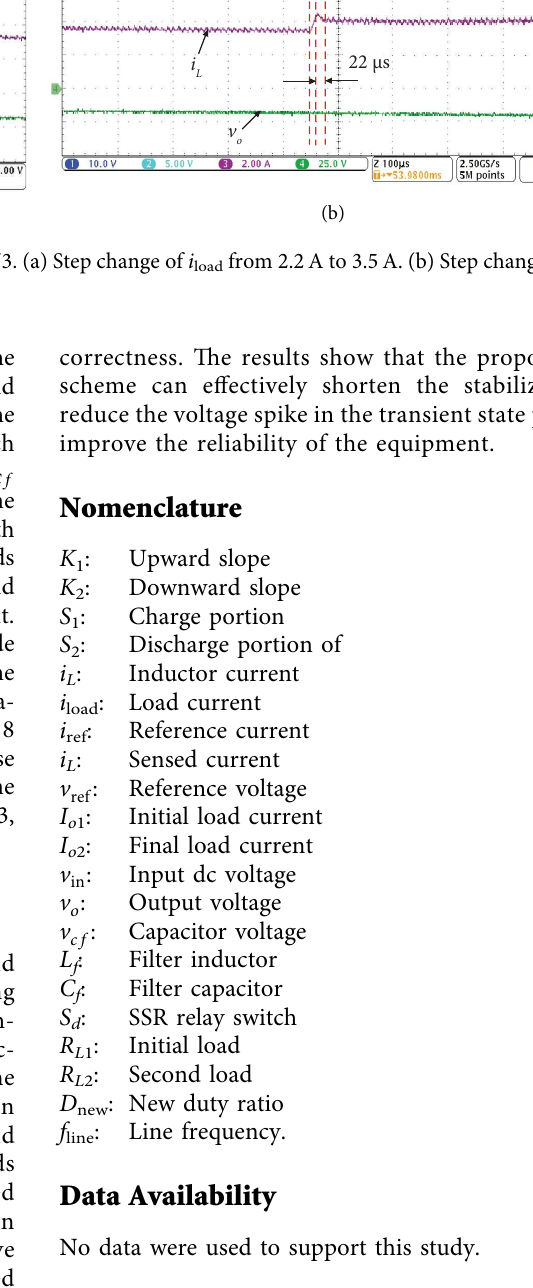
load from 2.2A to 3.5 A. (b) Step change of i load from